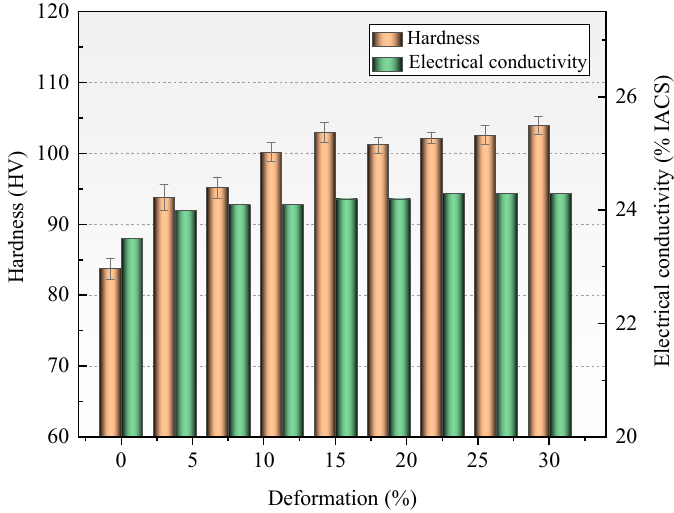
Figure 11. Hardness and electrical conductivity change with different deformation of the plate after annealed.